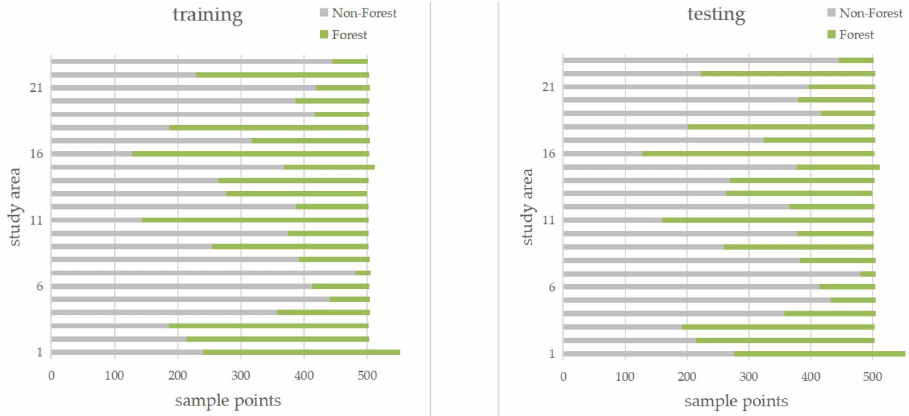
Figure 2. Number of sample sites in each study